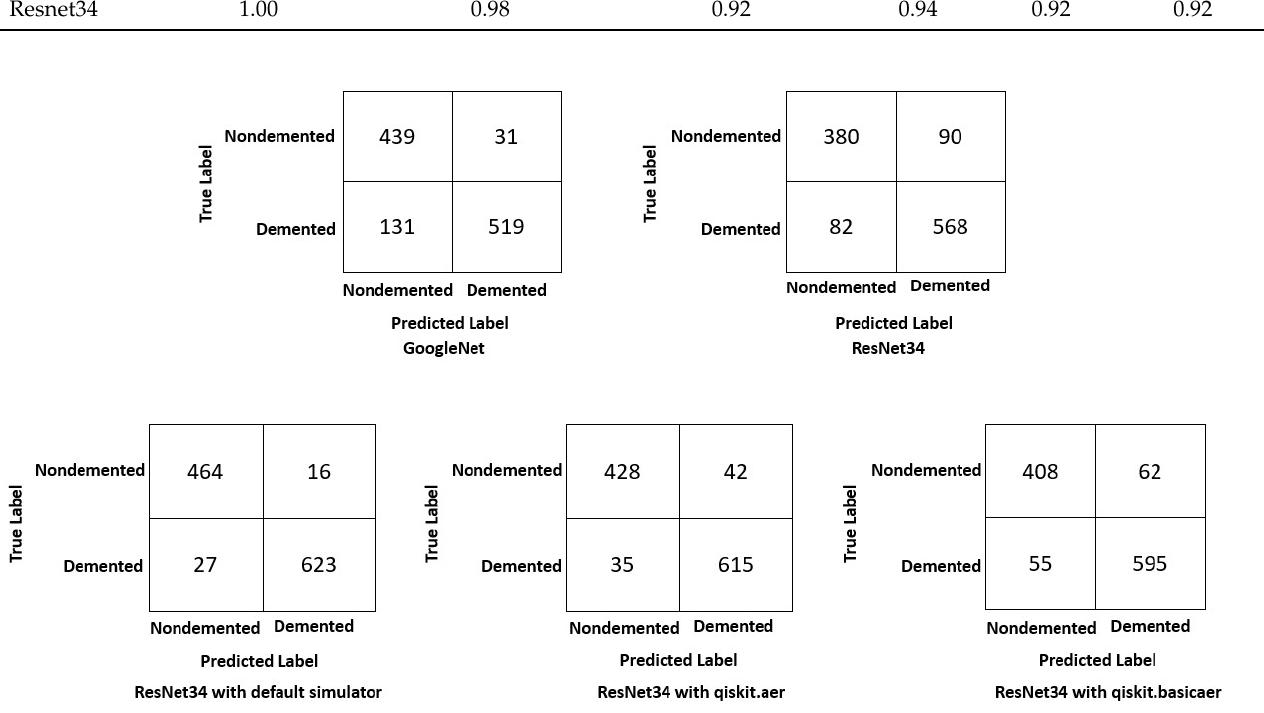
Figure 7. Confusion matrix for the demented and non-demented labels using GoogleNet, ResNet34 and different quantum simulators. Table 2. Results of the GoogleNet and ResNet34 models.